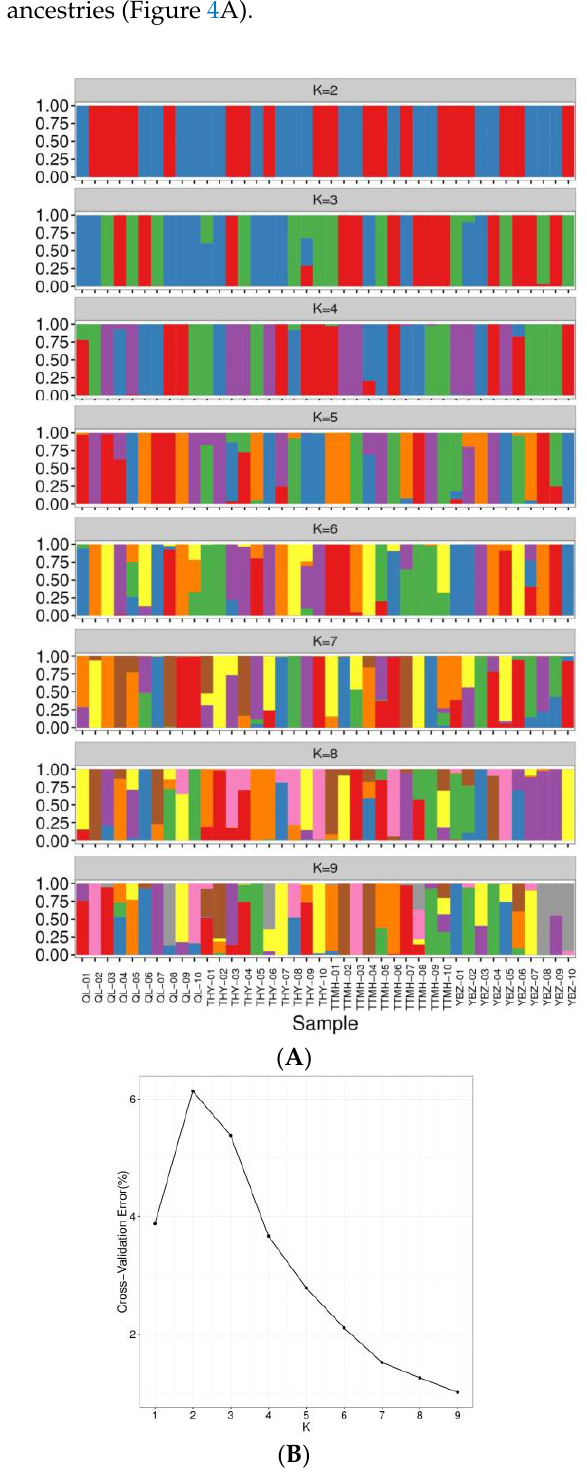
Figure 4. Analysis of the population structure from four locations. ( A ): Population structure of 40 individuals from different sites. ( B ): The admixture validation error rate corresponding to the different K values.